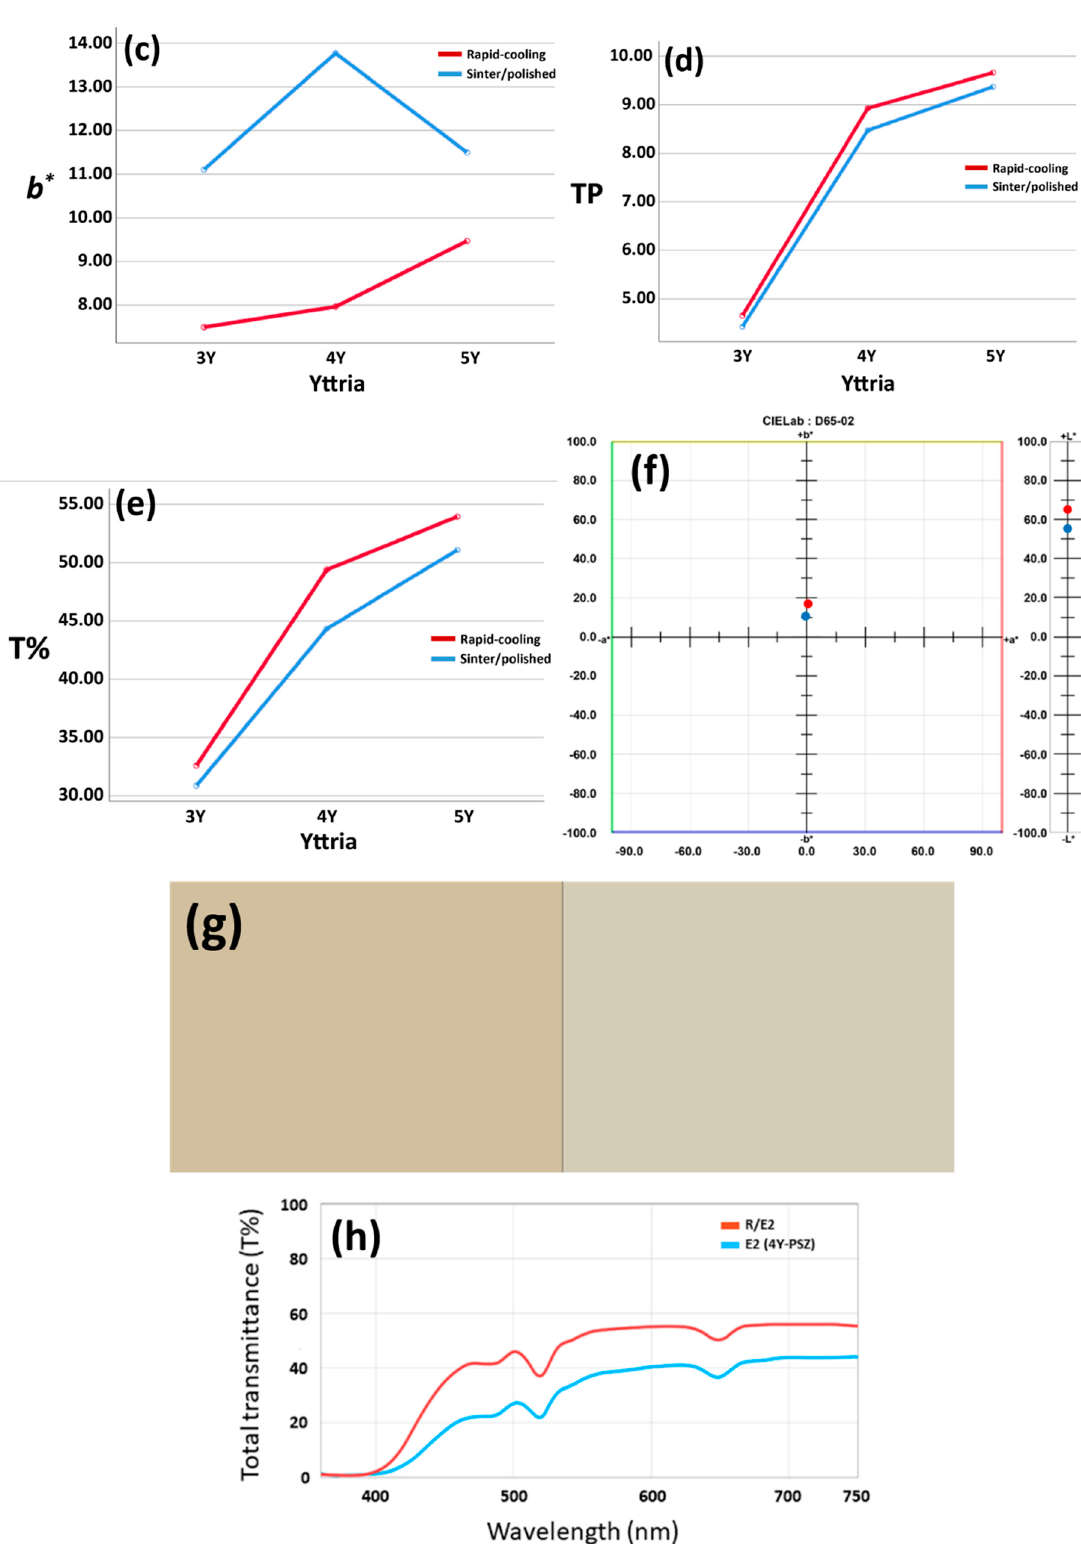
Figure 3. The changes of L * ( a ), a * ( b ), b * ( c ), TP ( d ), T%550 ( e ) values based on the results of a two-way ANOVA test. The changes in color ( f , g ) and total transmittance ( h ) after a rapid-cooling heat treatment.